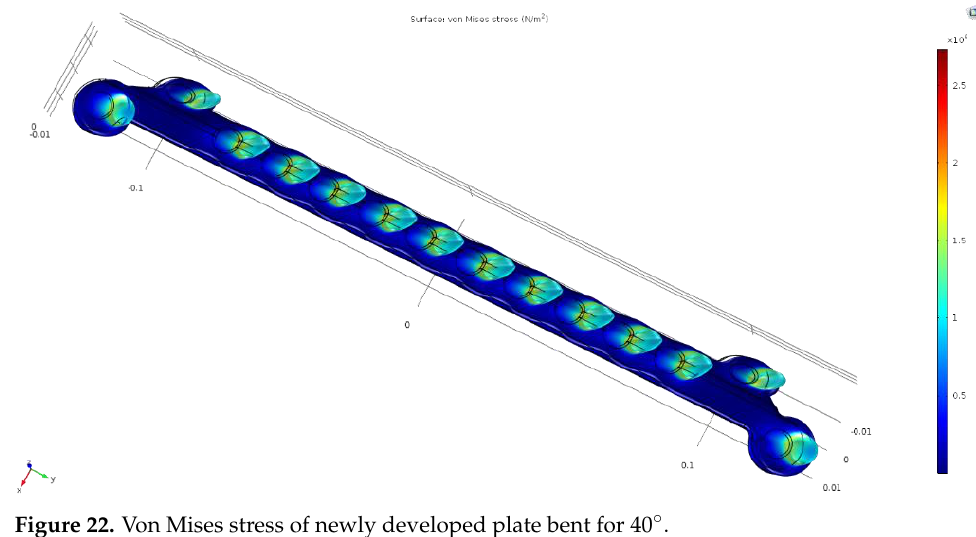
Figure 22. Von Mises stress of newly developed plate bent for 40°.